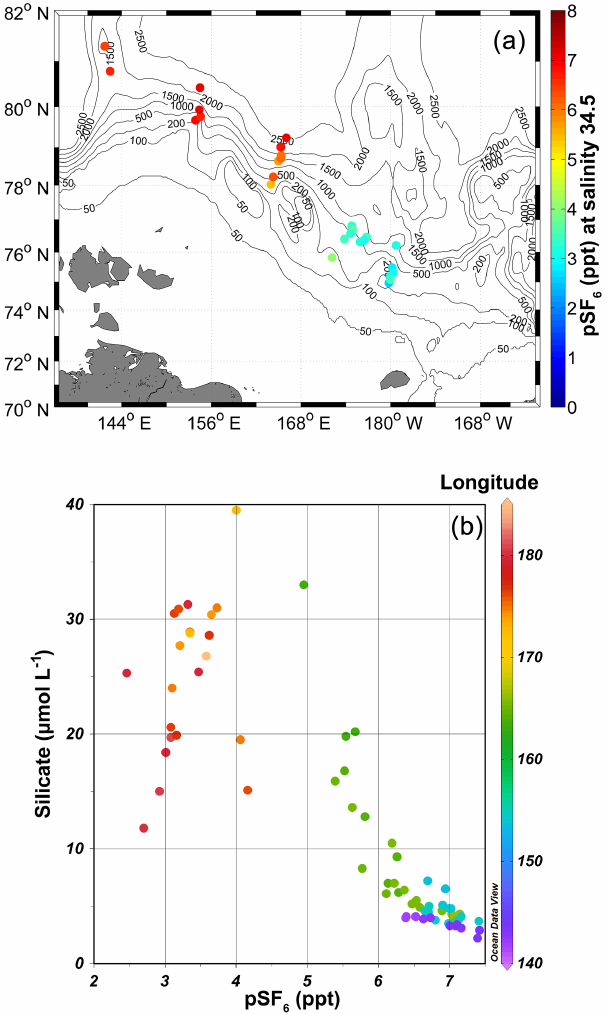
Figure 9. SF 6 partial pressure (ppt) interpolated to the salinity 34.5 (a) and silicate versus pSF 6 in the salinity range 34.3 to 34.7 colour coded by longitude (b)